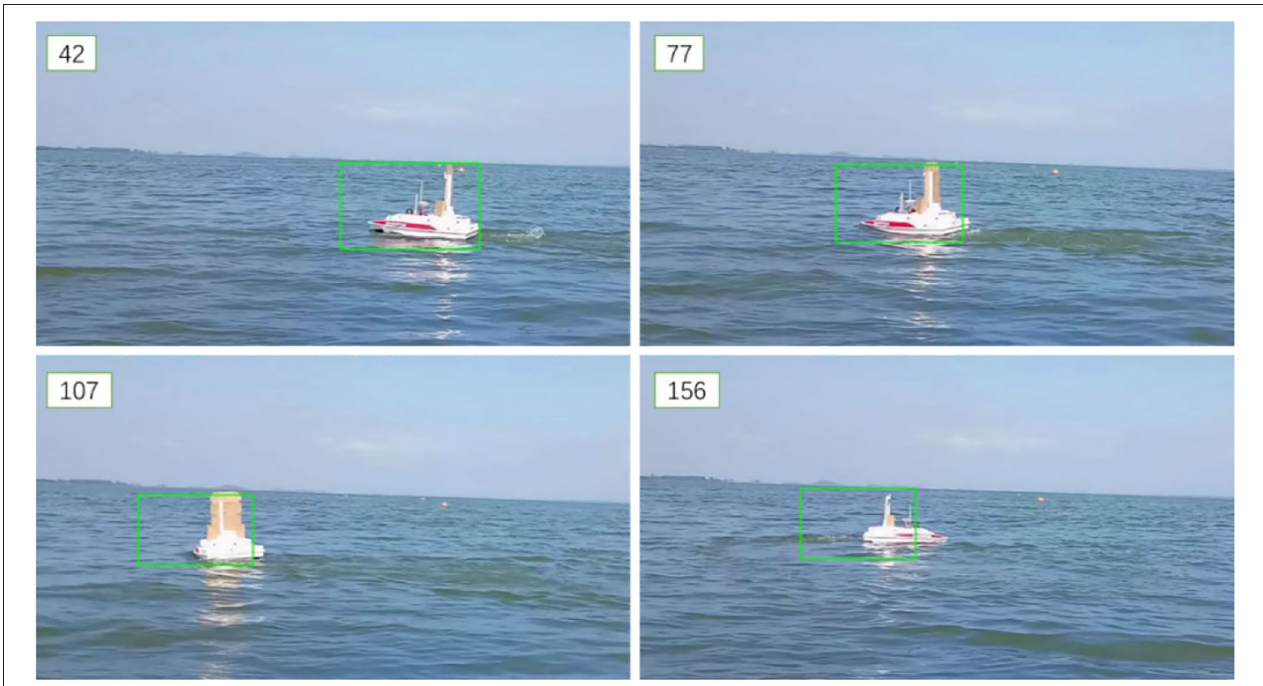
FIGURE 8 | The tracking drift